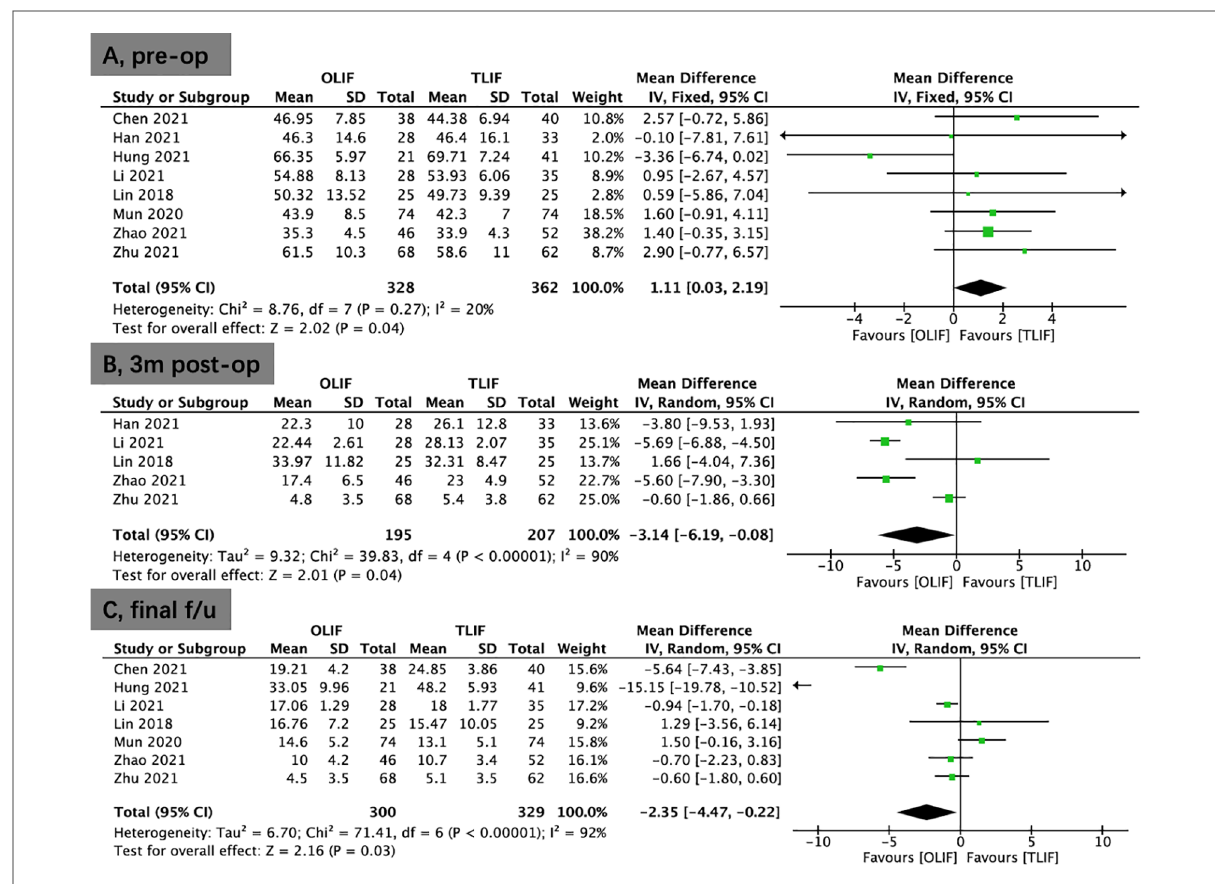
FIGURE 4 Forest plots for comparison of ODI at preoperative ( A ), early (3 months) postoperative ( B ), and fi nal follow-up ( C ) between OLIF and TLIF. ODI, oswestry disability index; OLIF, oblique lumbar interbody fusion; TLIF, transforaminal lumbar interbody